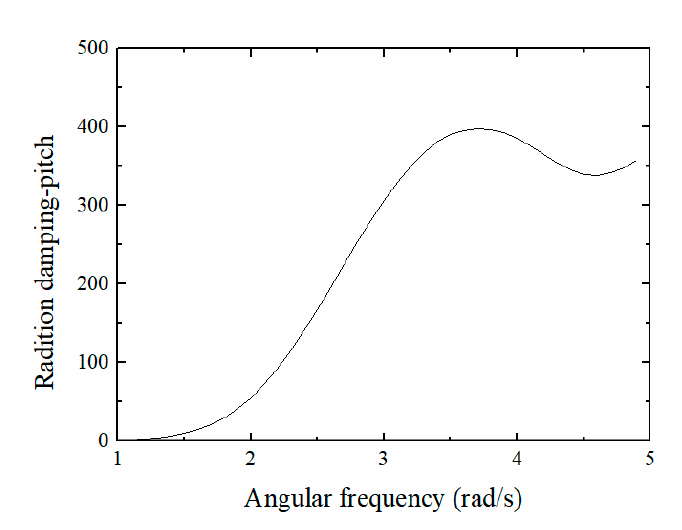
Figure 8. Radiation damping of the float in the pitching direction.